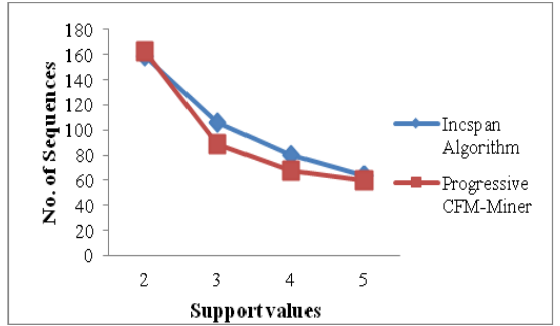
Fig.7. Execution Time Required With Different Support Values